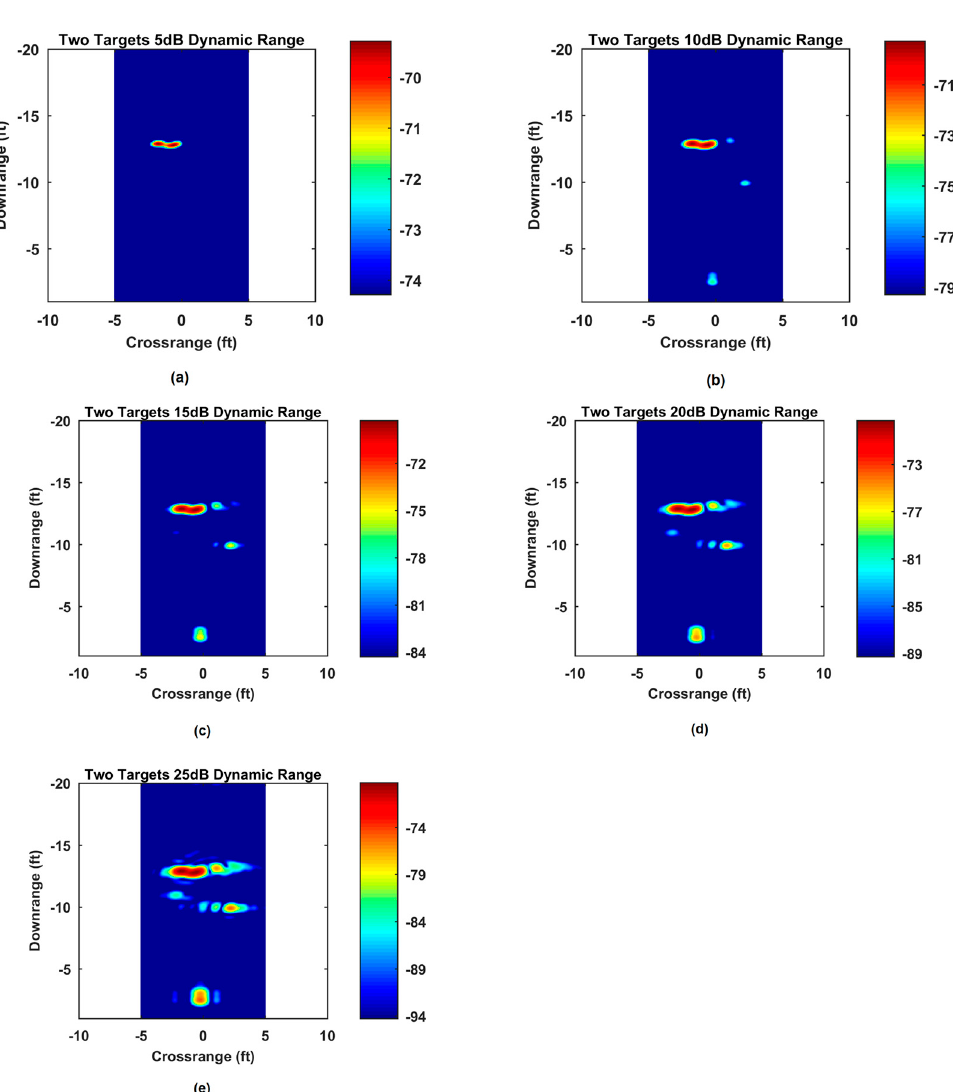
Figure 10. Images of multi-target View 1 over 5–25 dB image dynamic range: ( a ) 5 dB; ( b ) 10 dB; ( c ) 15 dB; ( d ) 20 dB; ( e ) 25 dB.